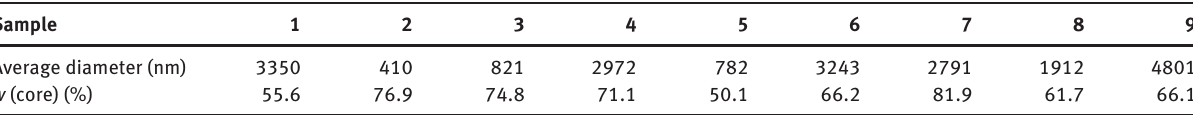
Table 3: Results of orthogonal test.